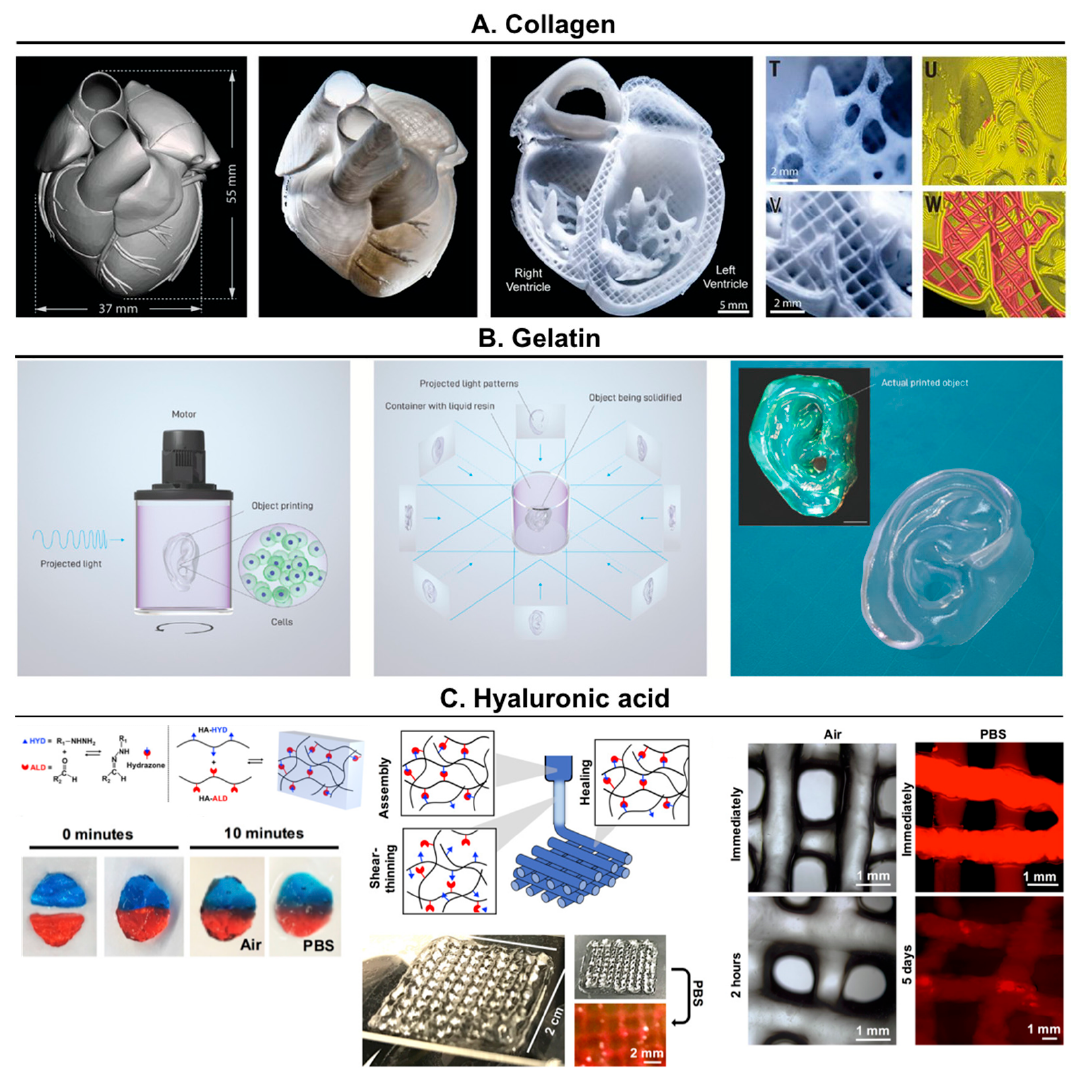
Figure 2. Examples of the use of natural proteins and polysaccharides for 3D bioprinting strategies. ( A ) Organ-scale 3D printing of collagen. Reproduced with permission from [21], copyright 2019, Springer Nature; ( B ) Volumetric bioprinting using gelatin with methacryloyl residues (GelMA). Reproduced with permission from [24] copyright 2019, The Authors; ( C ) Bioprinting of covalently crosslinked hyaluronic acid (HA) hydrogels. Reproduced with permission from [66], copyright 2018, Wiley Periodicals, Inc.